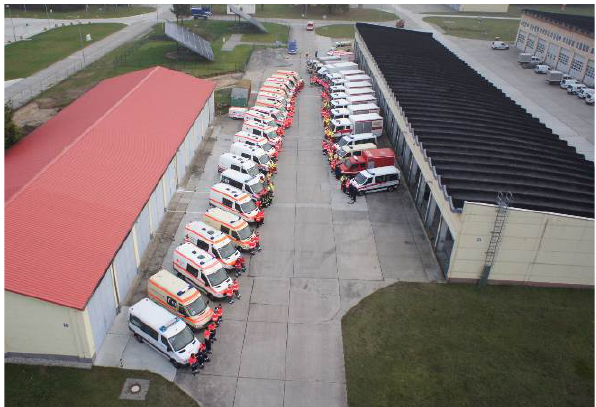
Figure 1: Participants of the exercise